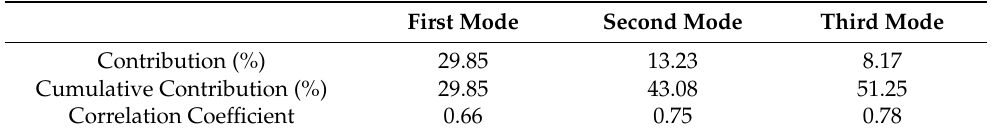
Table 1. The differences in the contribution rates of the first three SVD modes between the spring snowmelt over the TP and spring precipitation in NWC. First